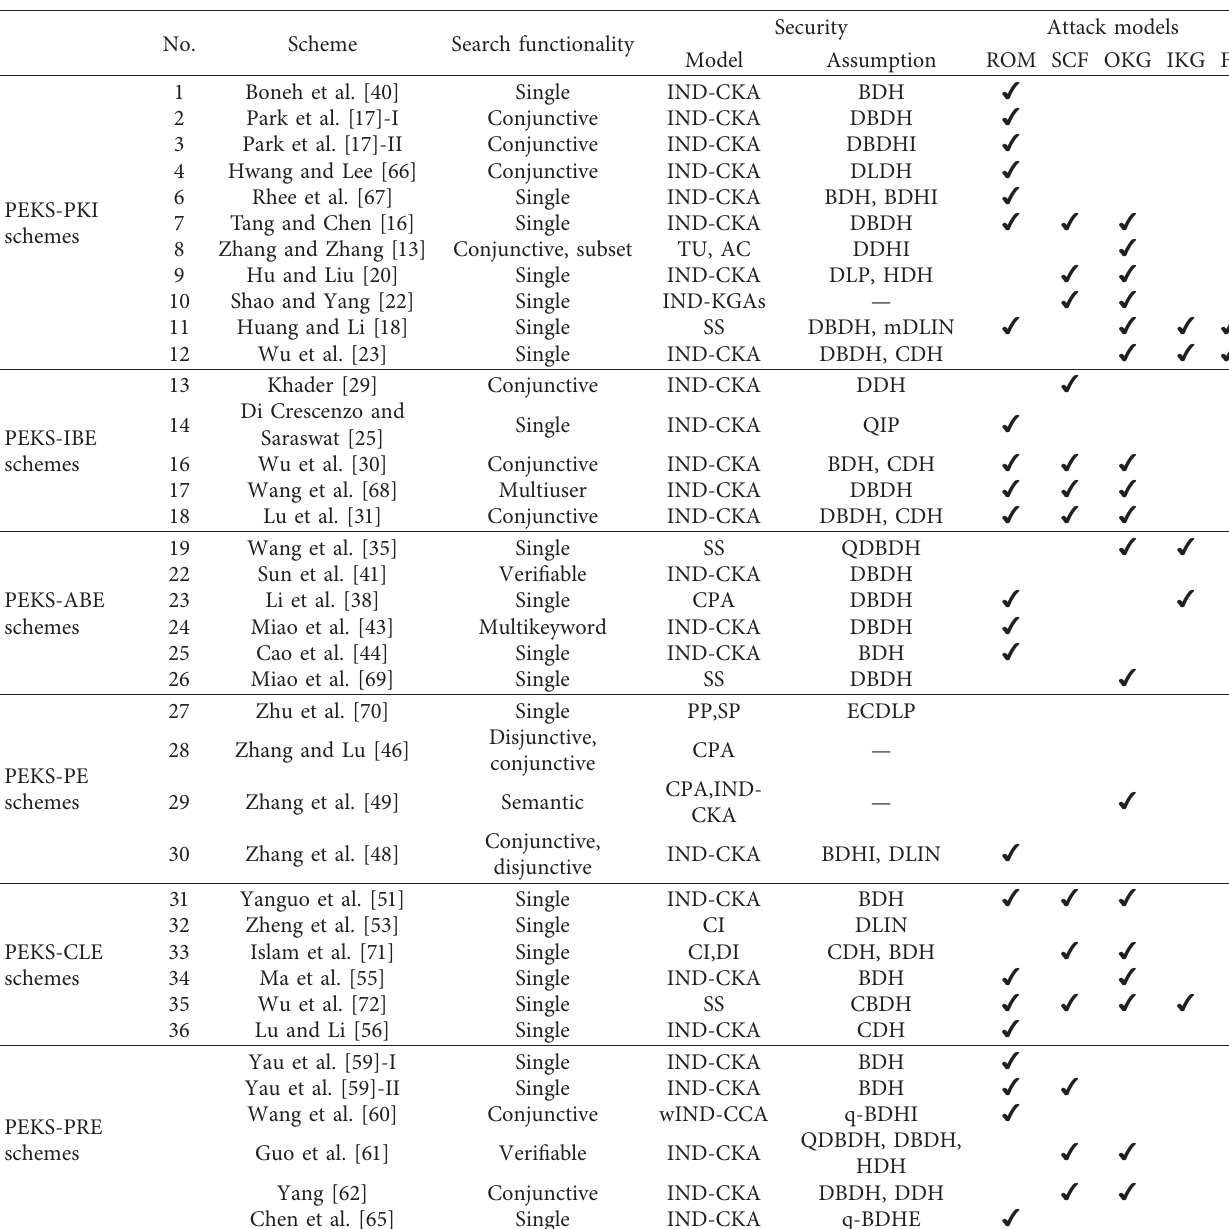
Table 1: Comparison of several PEKS